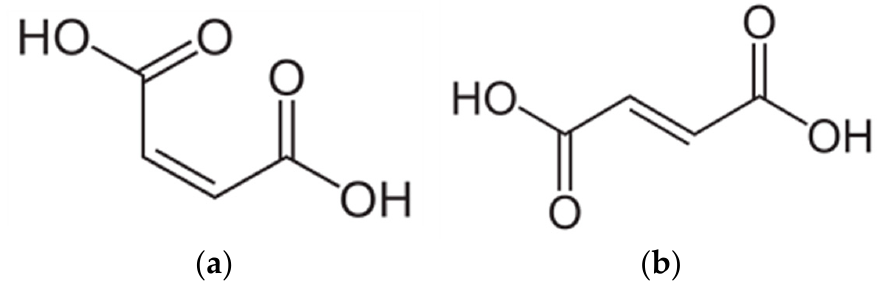
Figure 1. Structural formulas of maleic acid ( a ) and fumaric acid ( b ).